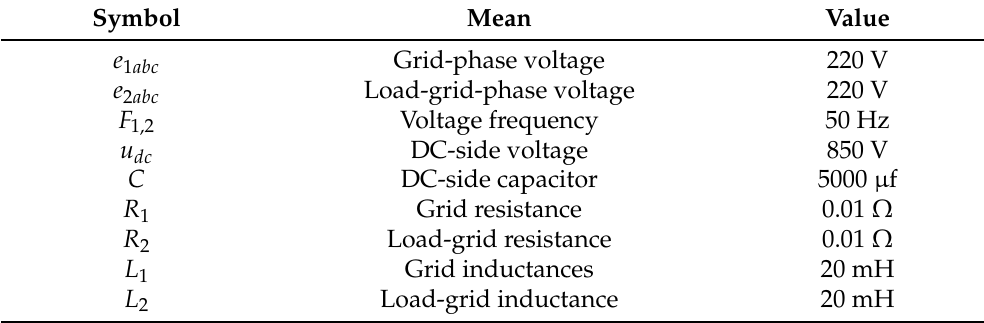
Table 1. The parameters of the SOP.